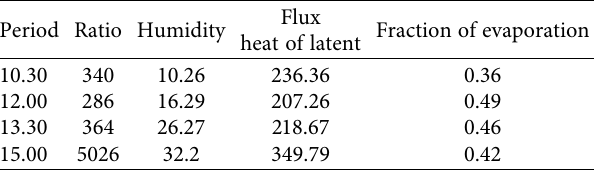
Table 3: Using energy balance, wecalculate the evaporative